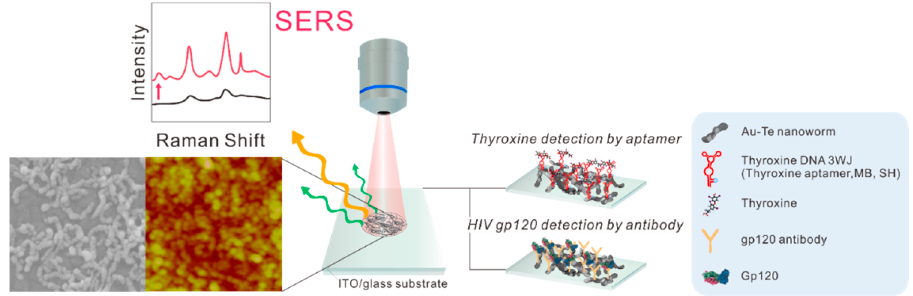
Figure 1. Schematic image of the fabricated biosensor platform. Note: SERS = surface-enhanced Raman spectroscopy, ITO = indium-tin-oxide.